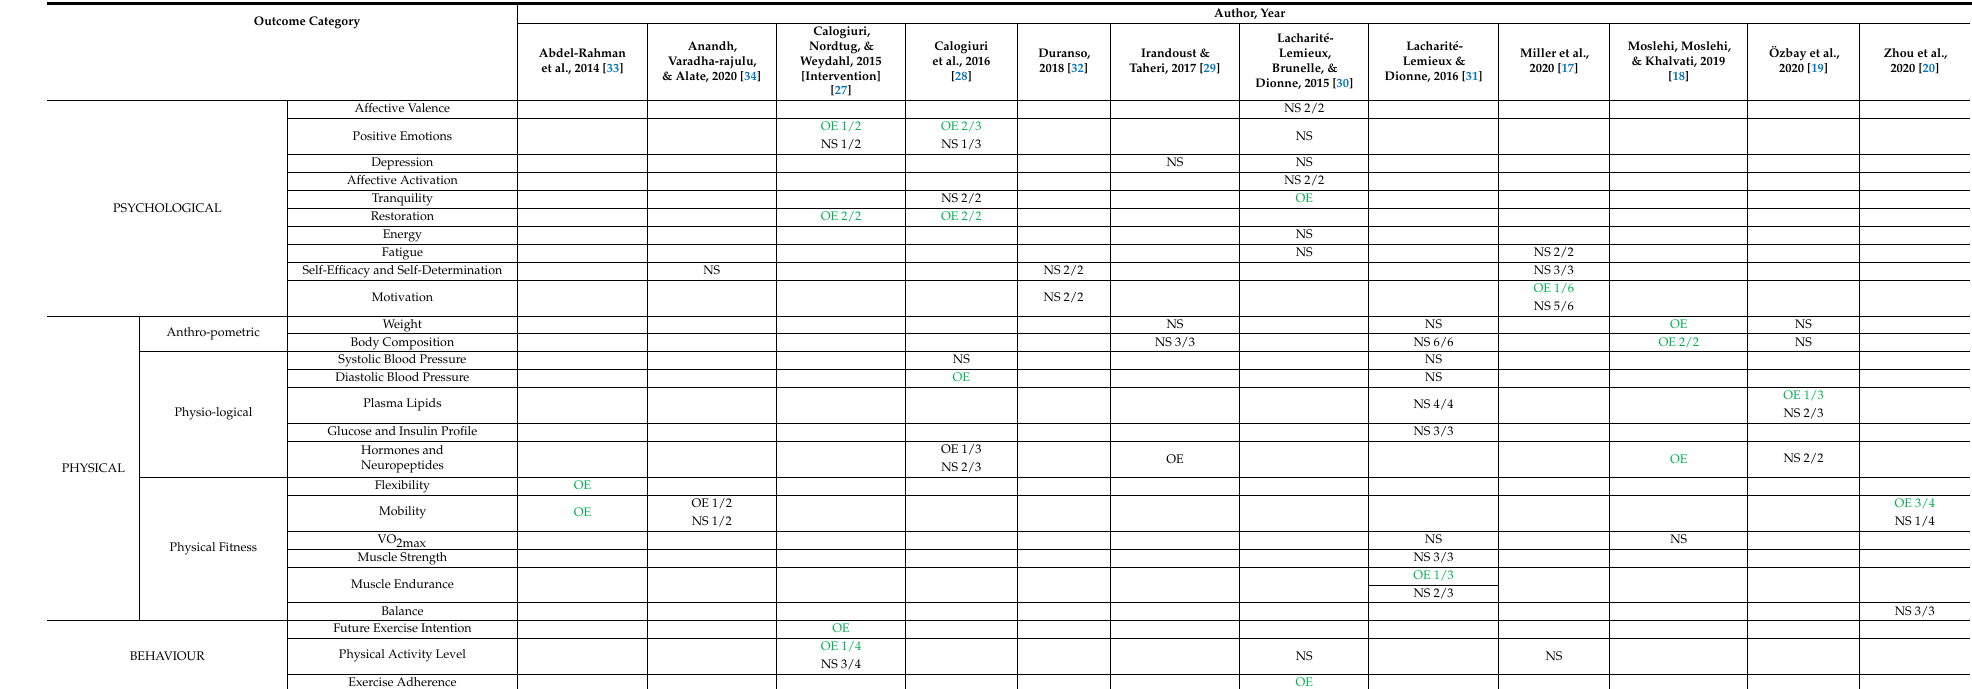
Outcome Categories: Refer to Table A1 for lists of discrete outcomes included within each outcome category. Symbols and Acronyms: ‘OE’: A statistically significant group difference was reported for one or more outcomes included in this category; the direction of the effect favoured outdoor exercise. ‘NS’: One or more outcomes included in this category were measured in the study; no statistically significant group differences were reported. [blank]: No outcomes in this category were measured in the study. Fractions represent the number of comparisons with the indicated result, out of the total number of comparisons measured in this